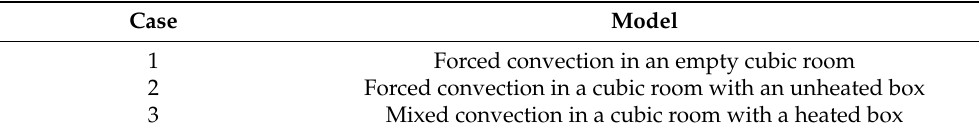
Figure 1. Sketch of a 3-D ventilated model room of 2.44 m × 2.44 m × 2.44 m in dimensions. ( a ) Inlet/outlet slots and a small cubic box; ( b ) Positions of ten measurement lines. Table 1. Summary of all three cases in a three-dimensional model